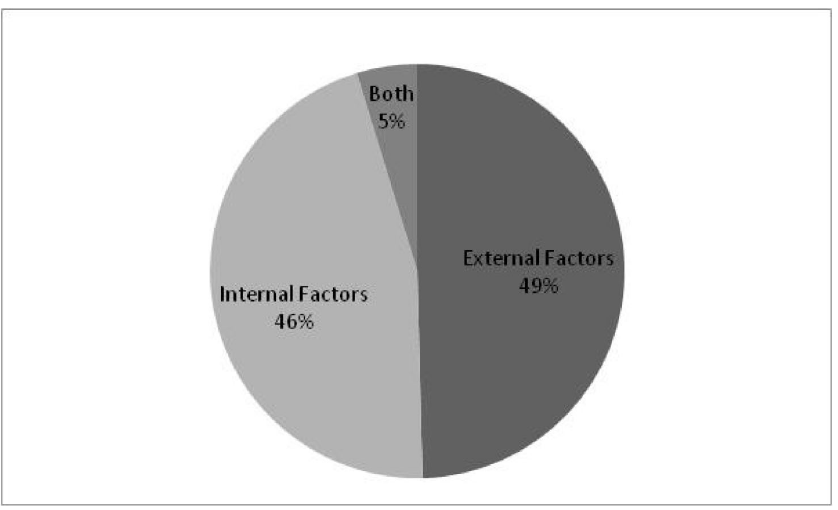
Figure 2. ISO 9001 certified firms driven by internal/external motivations (Internal VS